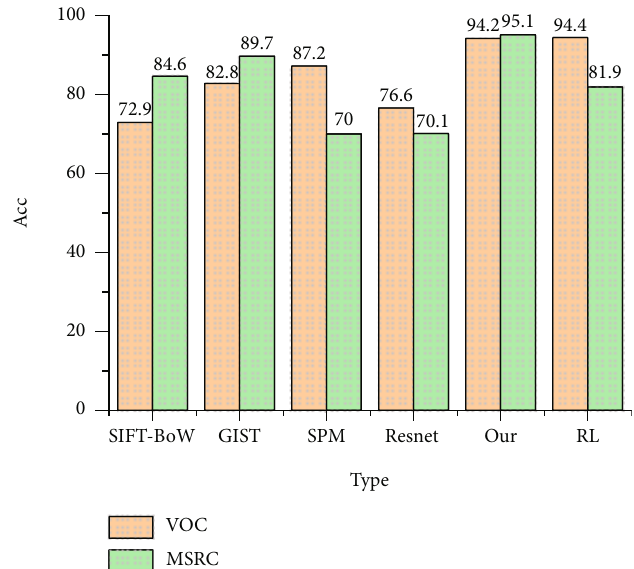
Figure 5: Accuracy of image classi fi cation under di ff erent methods.